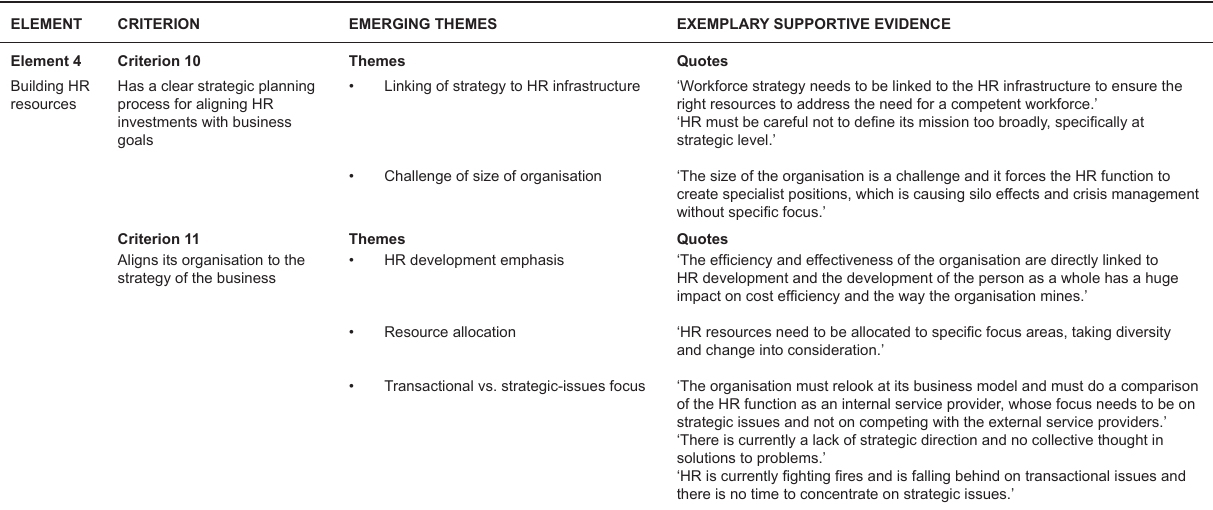
TABLE 5 Emerging themes pertaining to Element 4: Building HR